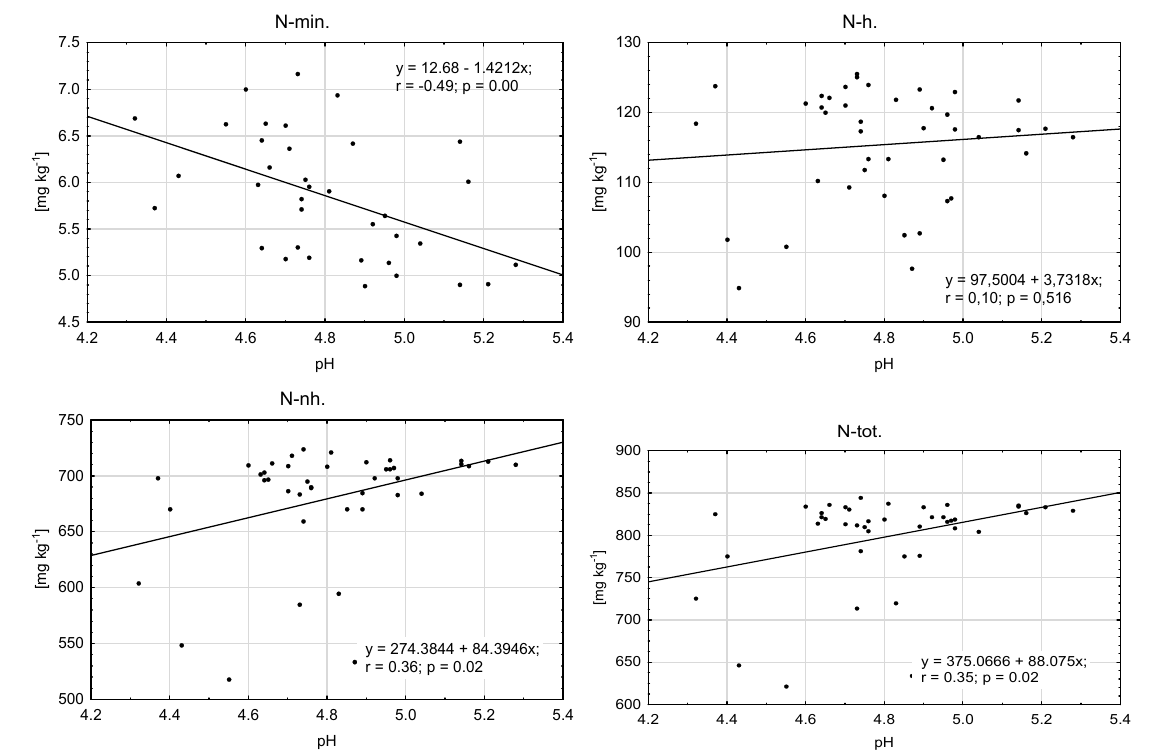
Figure 5. Content of selected N fractions depending on the soil pH (n = 42; N-min.—N-mineral; N-h.—hydrolysable (easily + hardly); N-nh.—non-hydrolysable; N-tot.—total).